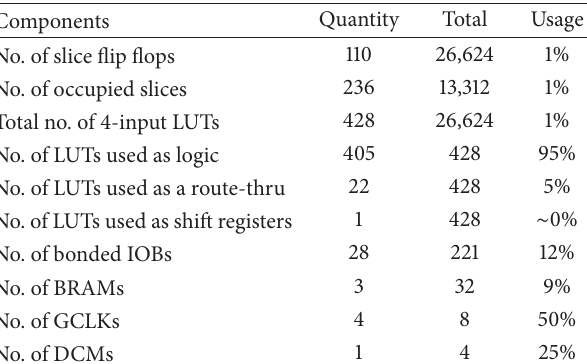
Table 6: Implementation results.